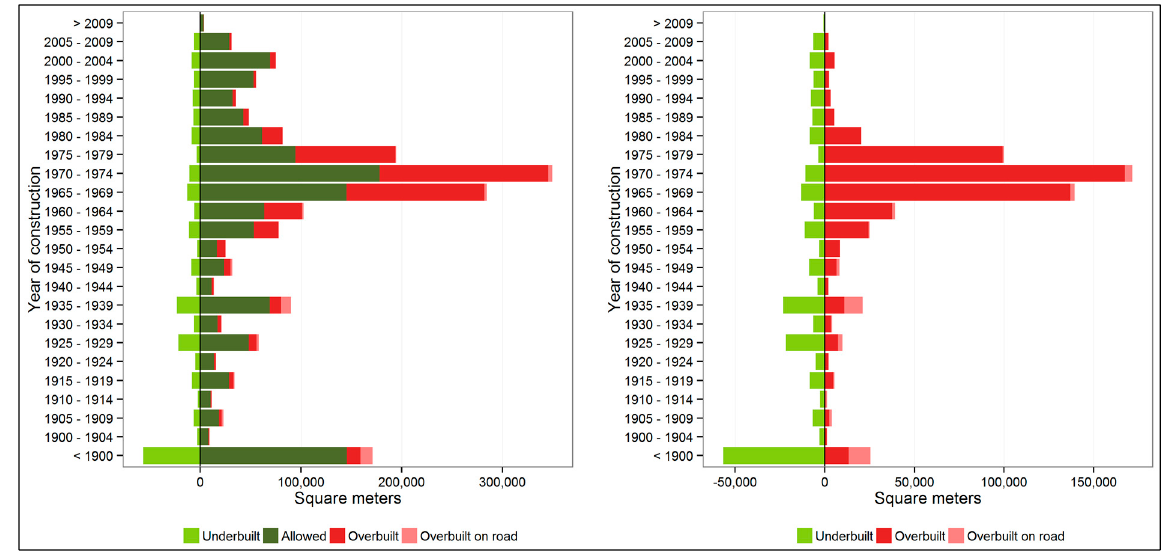
Figure 22. Distribution of legal status by year of